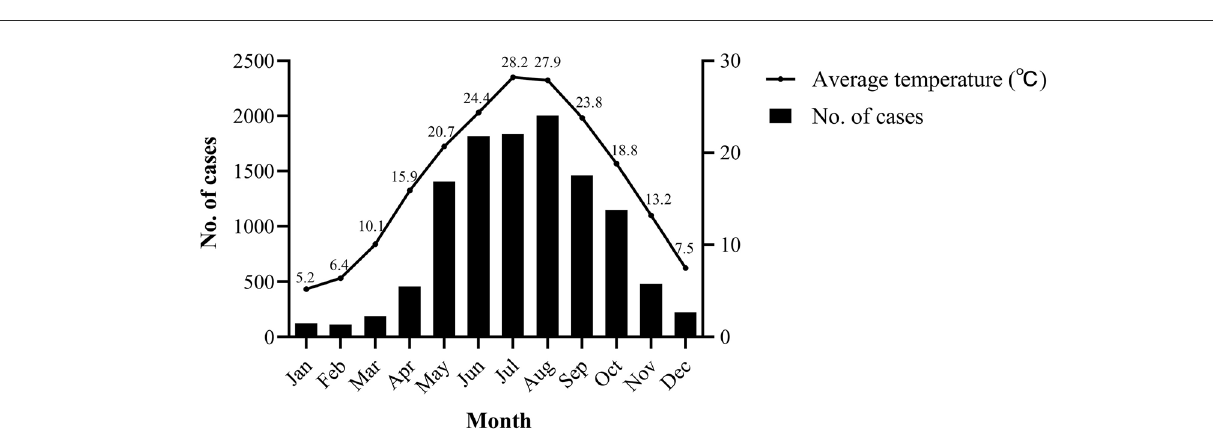
FIGURE3 Temporal distribution and number of Salmonella cases, by month of occurrence,